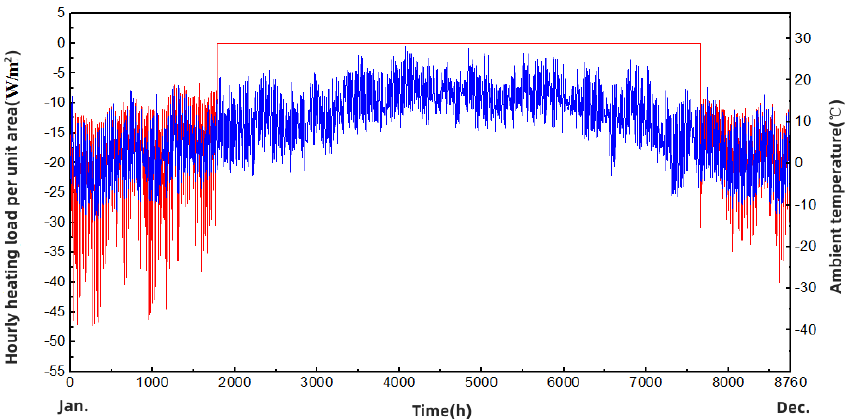
Figure 3. Hourly heating load per unit area and ambient temperature trend.